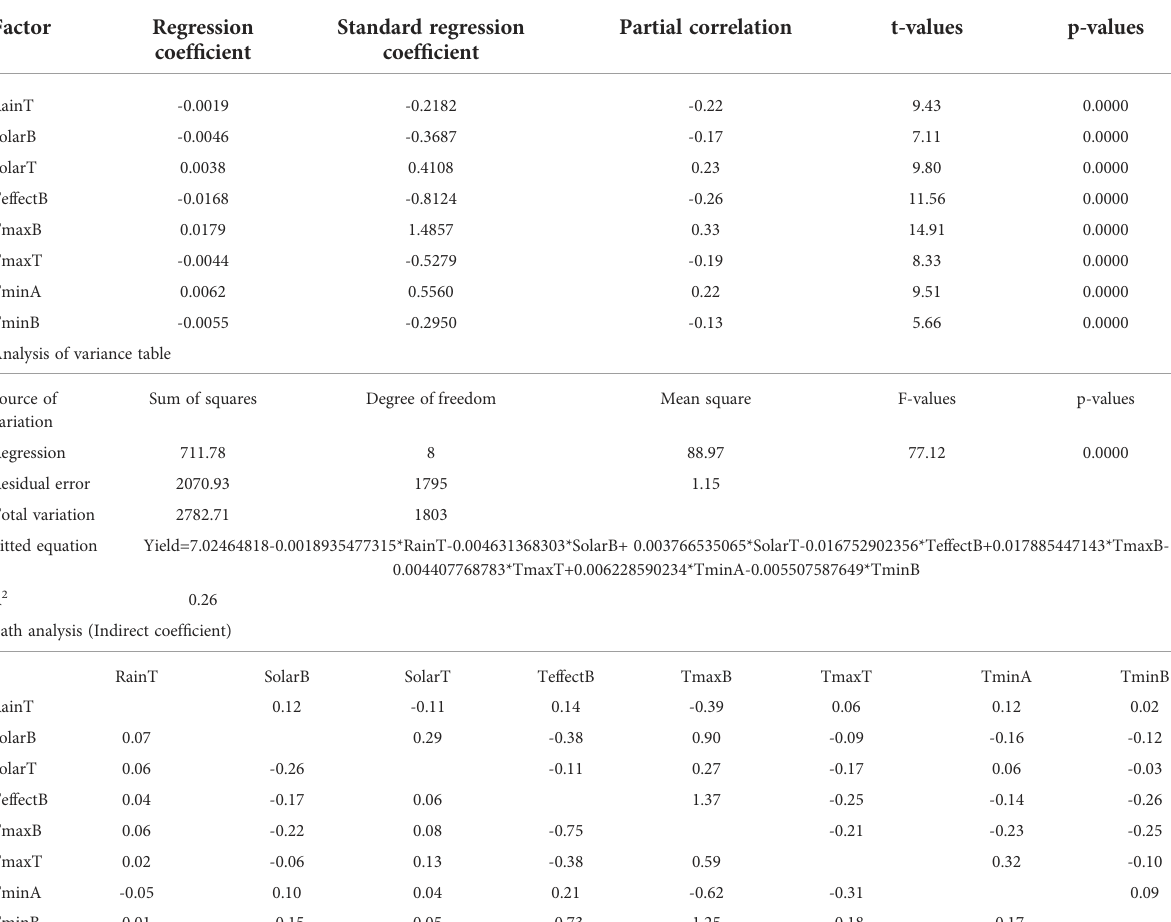
TABLE 6 Contribution rate of climatic factors to yield (Path analysis). Factor Regression coef fi